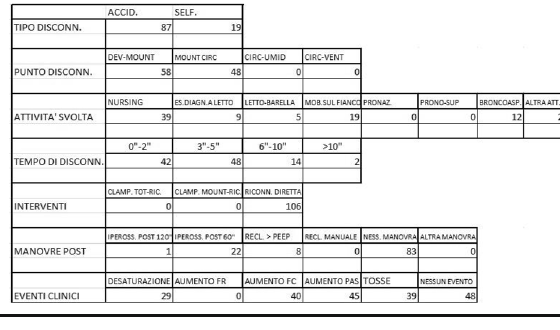
Table 2 (abstract A34). Results of sedation associated to ultrasound- guided thoracic fascial plane block